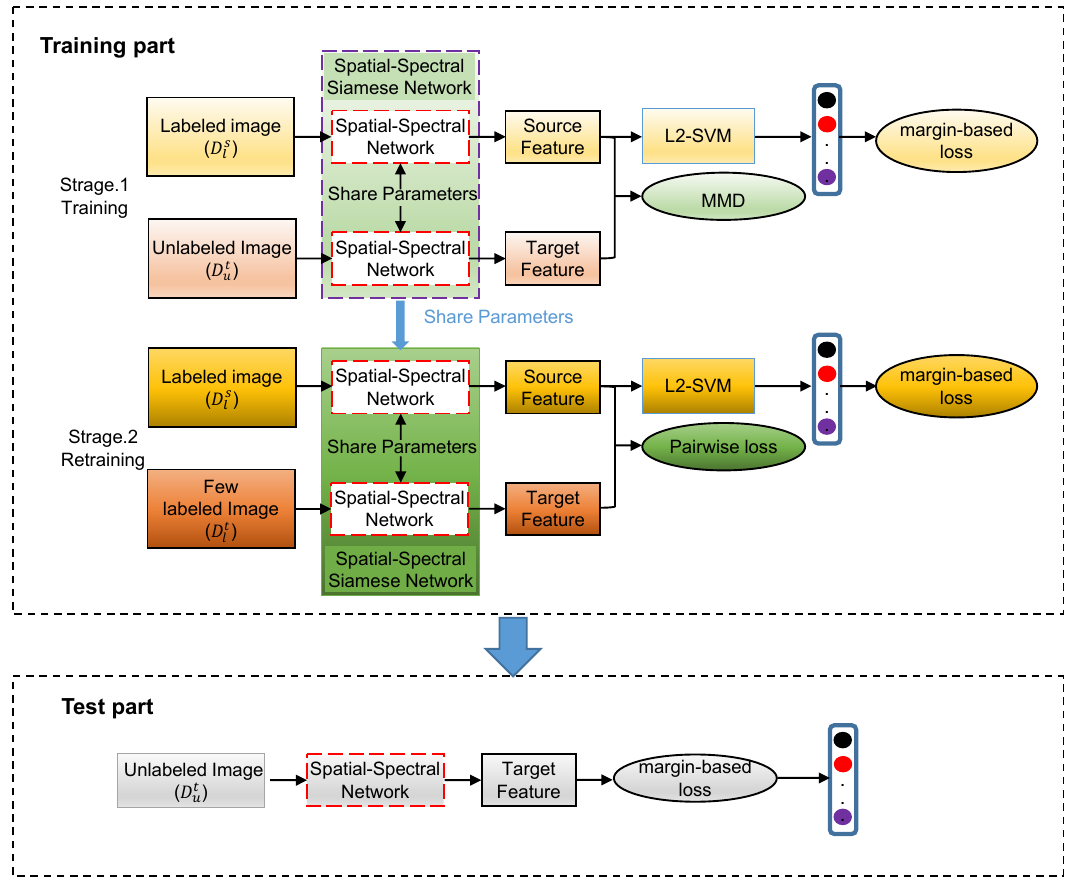
Figure 1. The Framework of the two-stage deep domain adaptation (TDDA) method.